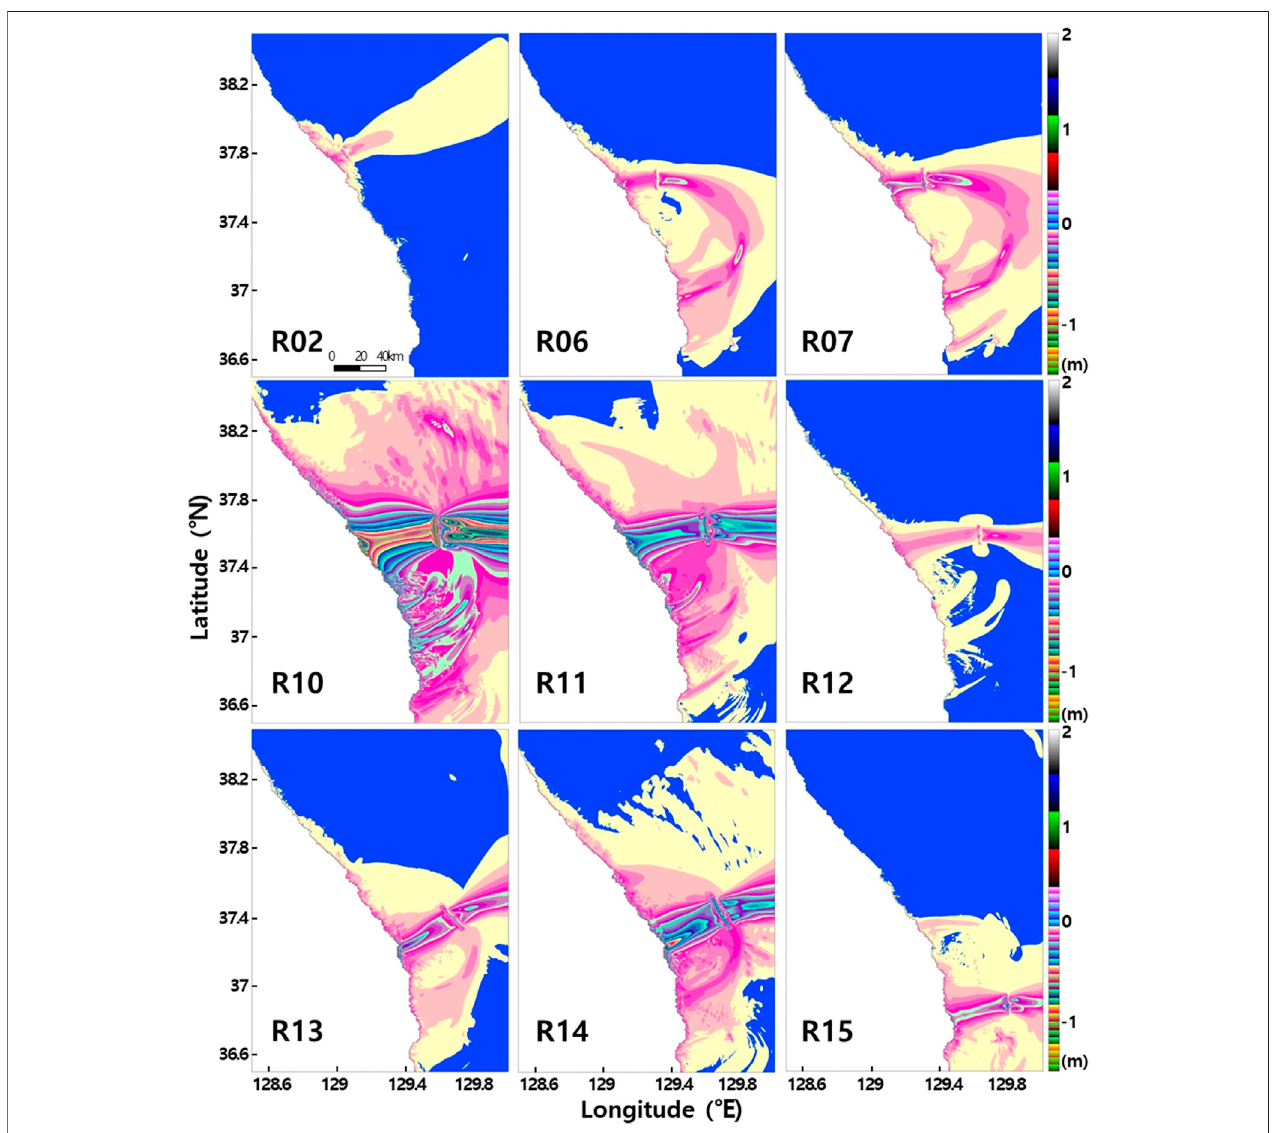
FIGURE 9 | Lowest elevation of tsunamis in the East Sea, estimated from numerical modeling for different scenarios (fault zones; Combination B).